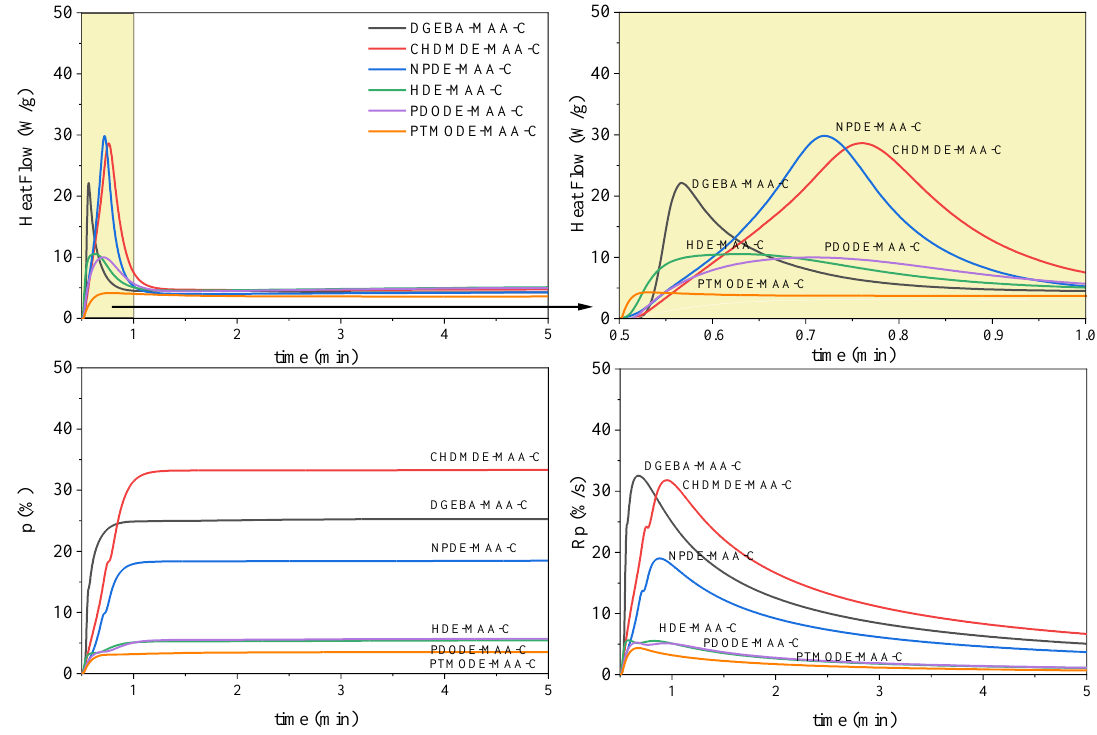
Figure 3. Photo-DSC exotherms for the cationic (C) photopolymerization of epoxy methacrylate formulations (diglycidyl ether-MAA).